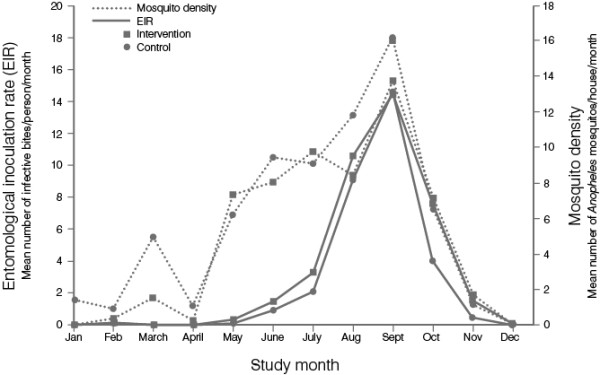
Temporal variation of
Anopheles
density and entomological inoculation rate (EIR) by study arm.